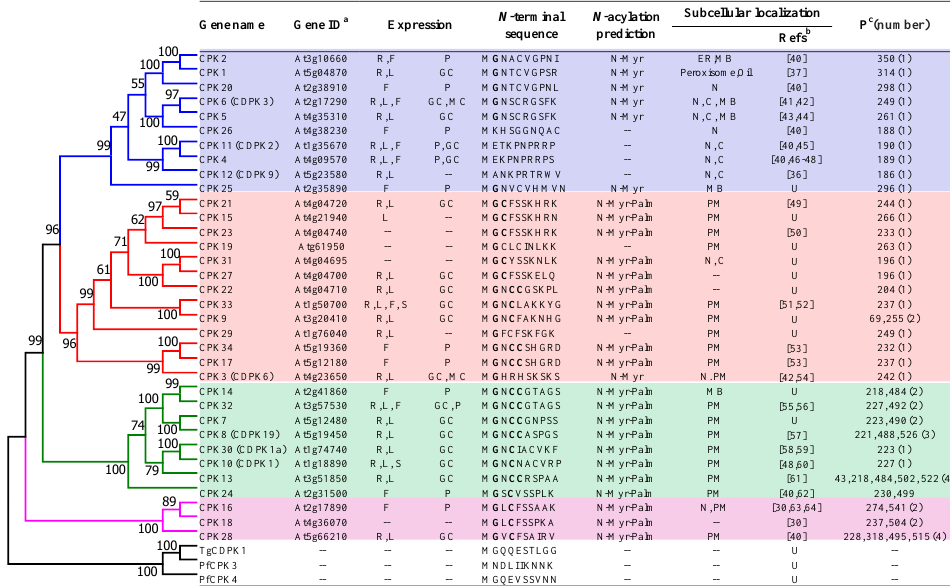
Figure 1. Phylogenetic relationships and characteristics of selected calcium-dependent protein kinases (CDPKs) (modified from [25]). The full-length amino acid sequences of CDPKs from A. thaliana , P. falciparum , and T. gondii were analyzed by MEGA7.0 and UniProt (https://www.uniprot.org/). Arabidopsis thaliana CDPKs (AtCDPKs) are divided into four major subgroups (I–IV). R, root; L, leaf; F, flower; S, silique; GC, guard cell; P, pollen tube cell; MC, mesophyll cell; N, nucleus; C, cytoplasm; PM, plasma membrane; MB, membrane; ER, endoplasmic reticulum; –, not determined. G , the N -myristoylation site. C , the palmitoylation site. U, UniProt Knowledgebase. a Systematic designation given to a gene according to TAIR (www.arabidopsis.org) and UniProt (www.uniprot.org). b , References related to subcellular localization of CPKs: [30,36,37,40–64]. c , the position of phosphoserine